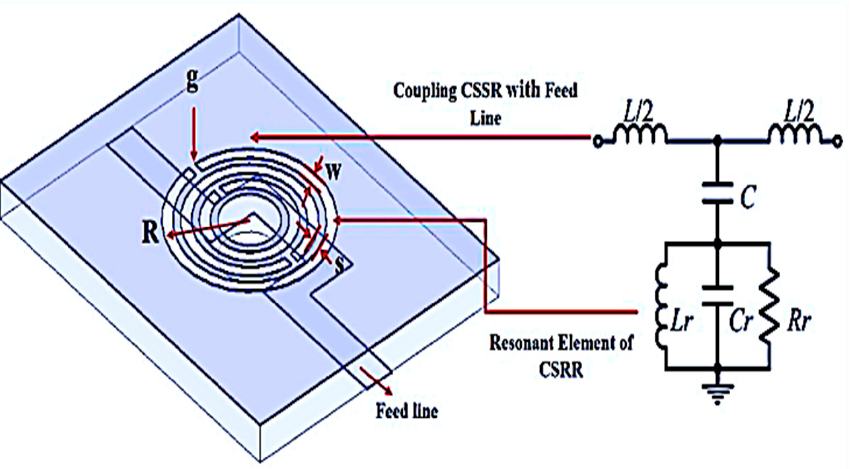
Figure 1. Triple-rings structure and its equivalent circuit.